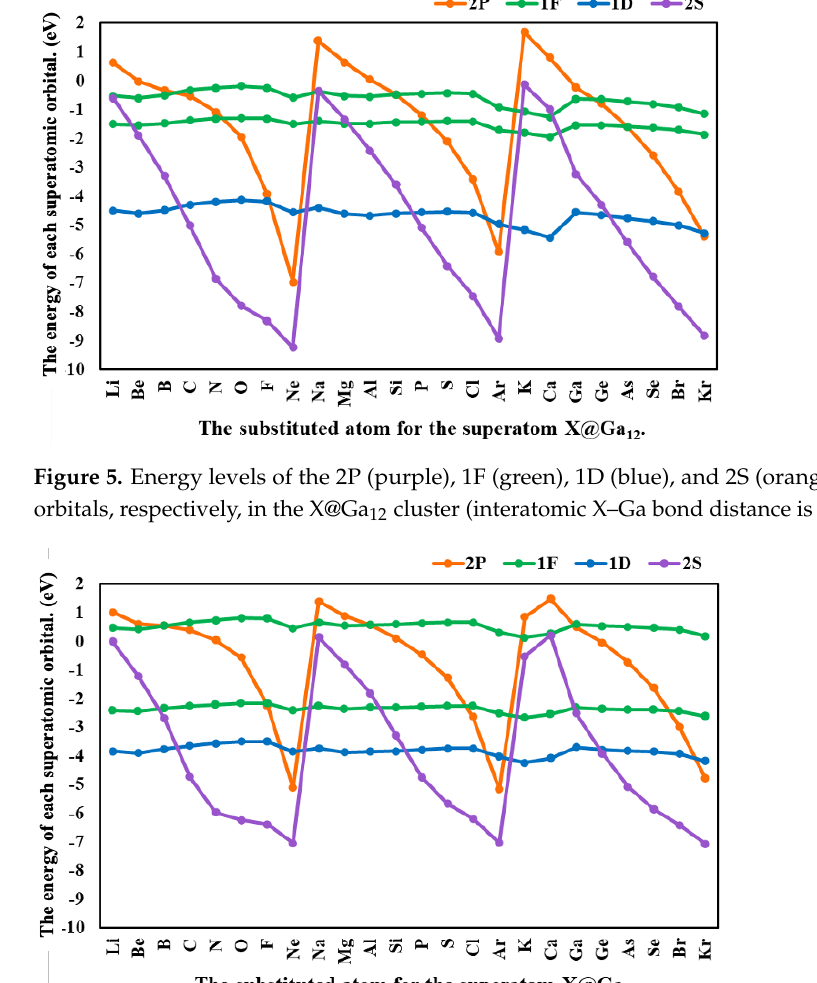
Figure 6. Energy levels of the 2P (purple), 1F (green), 1D (blue), and 2S (orange) superatomic-like